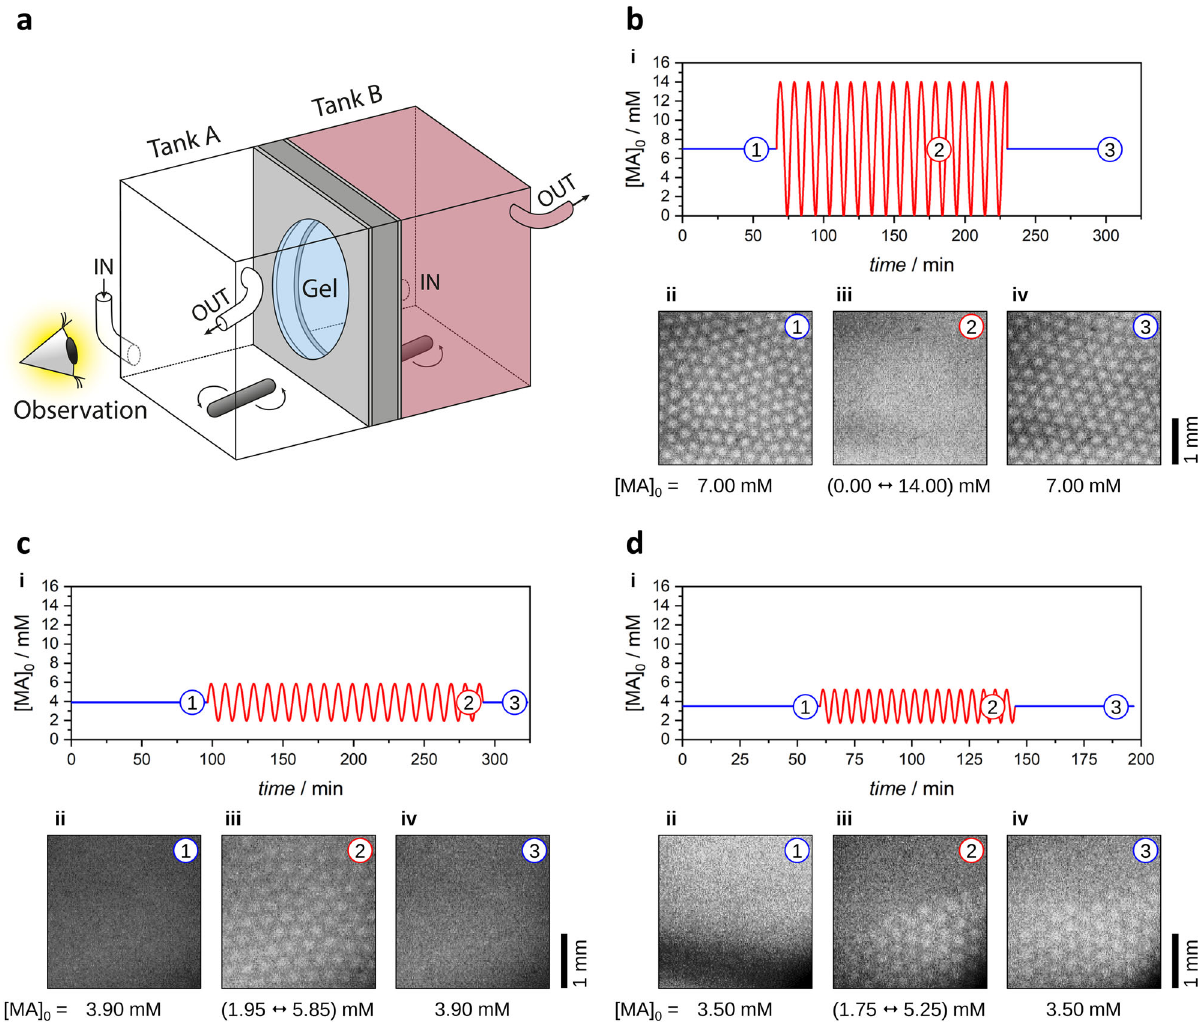
Fig. 2 Periodic forcing of the feed concentration of MA in experiments. The sketch of the experimental system ( a ). Disappearance of stationary Turing spots induced by the periodic forcing of the feed concentration of the MA. The initial [MA] 0,basis = 7.00 mM was modulated with ±100% amplitude and a time period of 10 min ( b ). Generation of stationary Turing spots induced by the periodic forcing of the feed concentration of the MA. The initial [MA] 0 , basis = 3.90 mM was modulated with ±50% amplitude and a time period of 10 min ( c ). The appearance and locking of stationary Turing spots induced by the periodic forcing of the feed concentration of the MA. The initial [MA] 0,basis = 3.50 mM was modulated with ±50% amplitude and a time period of 5 min ( d ). In fi gures b – d : (i) change of the concentration of the MA in the tank ([MA] 0 ) during the whole experiment. (ii) – (iv) Snapshots of the stabilized behavior with constant [MA] 0 before the forcing (1), periodic [MA] 0 during the forcing (2), and constant [MA] 0 after the forcing